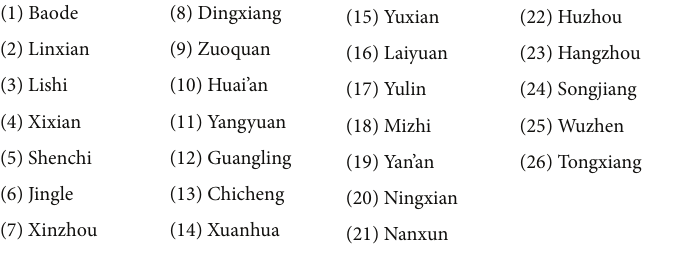
Figure 1: Abrupt cooling in 1601 AD in China and Korea. Dots denote records of abrupt cooling and epidemics, and different dots denote different seasons. Squares denote sites of relevant tree ring